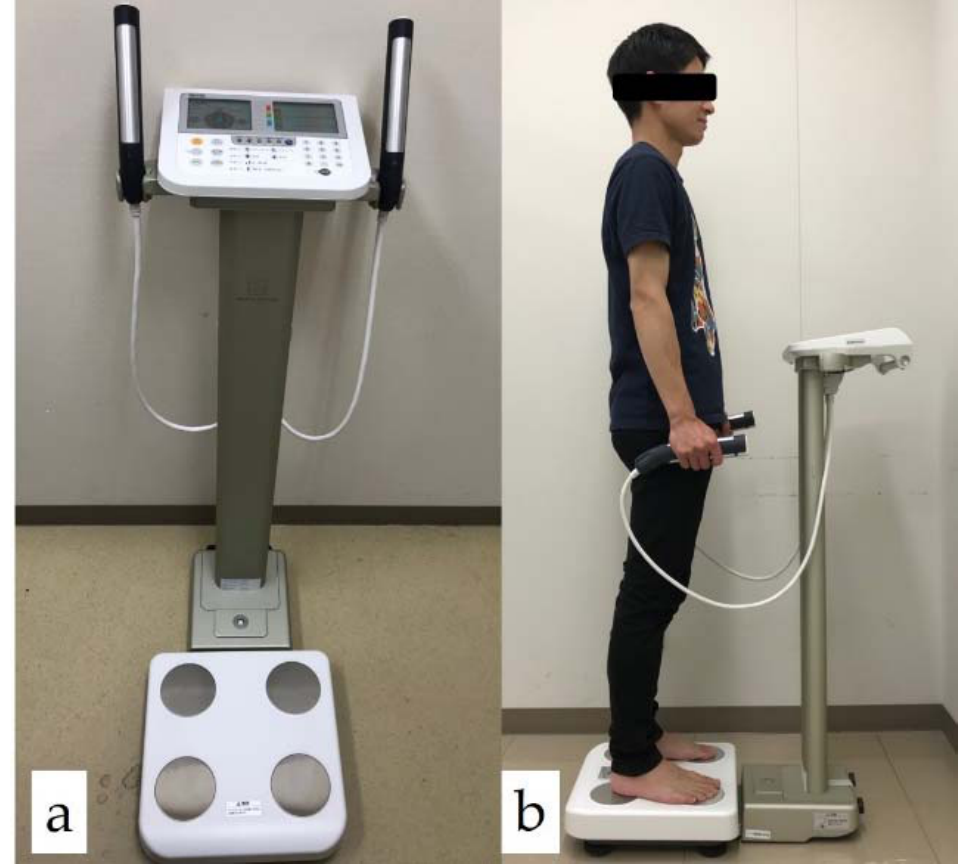
Figure 1. Measurement device (MC–780A) for the skeletal muscle mass index (SMI): ( a ) main unit; ( b ) measurement image.